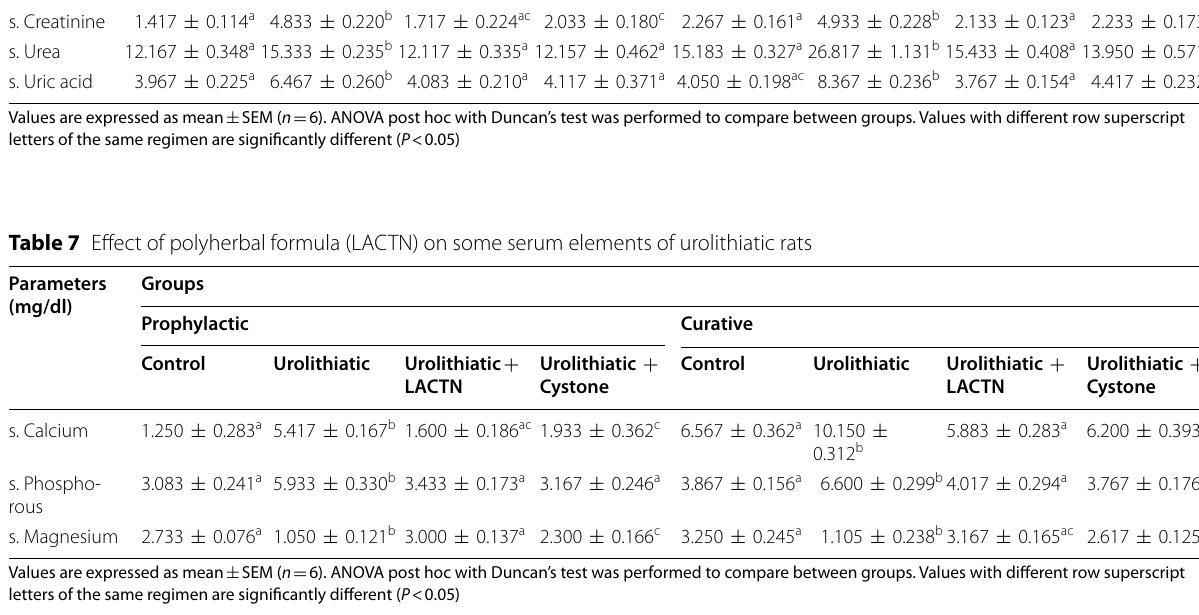
Values are expressed as mean SEM ( n 6). ANOVA post hoc with Duncan’s test was performed to compare between groups. Values with different row superscript ± = letters of the same regimen are significantly different ( P < 0.05)